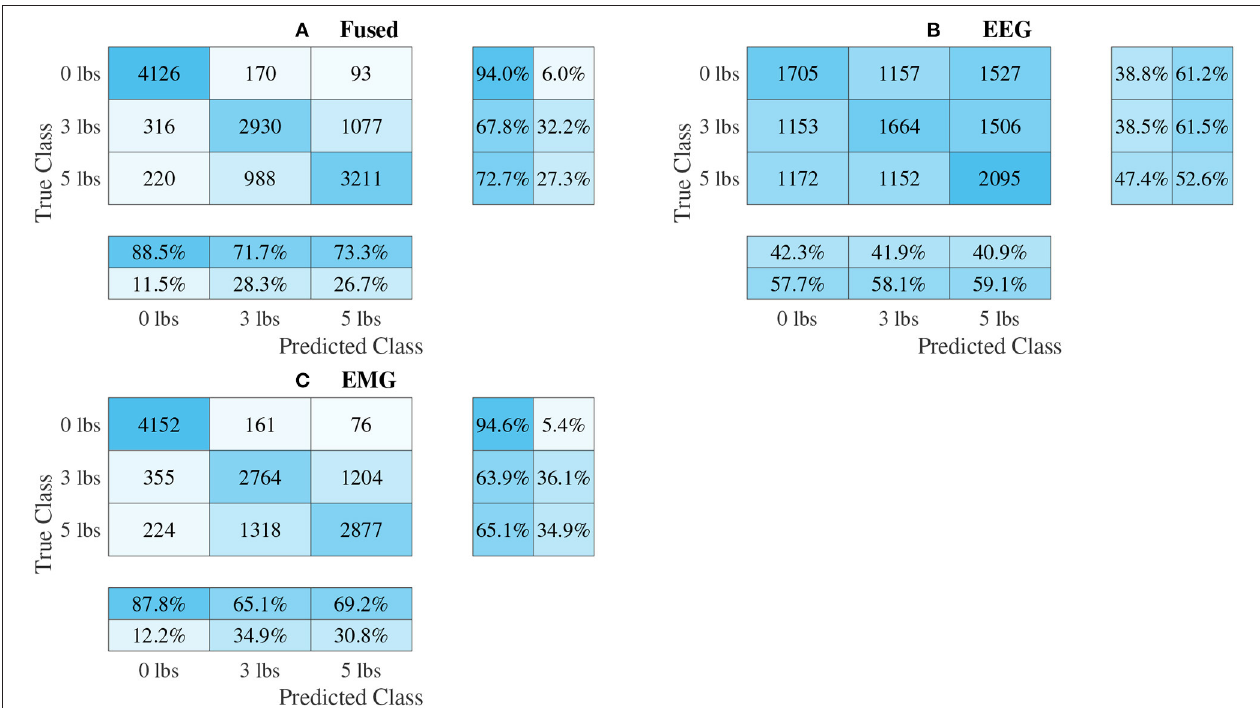
FIGURE 12 | Confusion matrices, using the combined classification results for all subjects, for the 1D convolution signal-image-based CNN models. (A) Shows the matrix for the EEG–EMG fusion model, while (B,C) how the matrices for the EEG and EMG only models, respectively. Each matrix contains a positive/negative precision score summary in the final two rows, and a positive/negative recall score summary in the final two